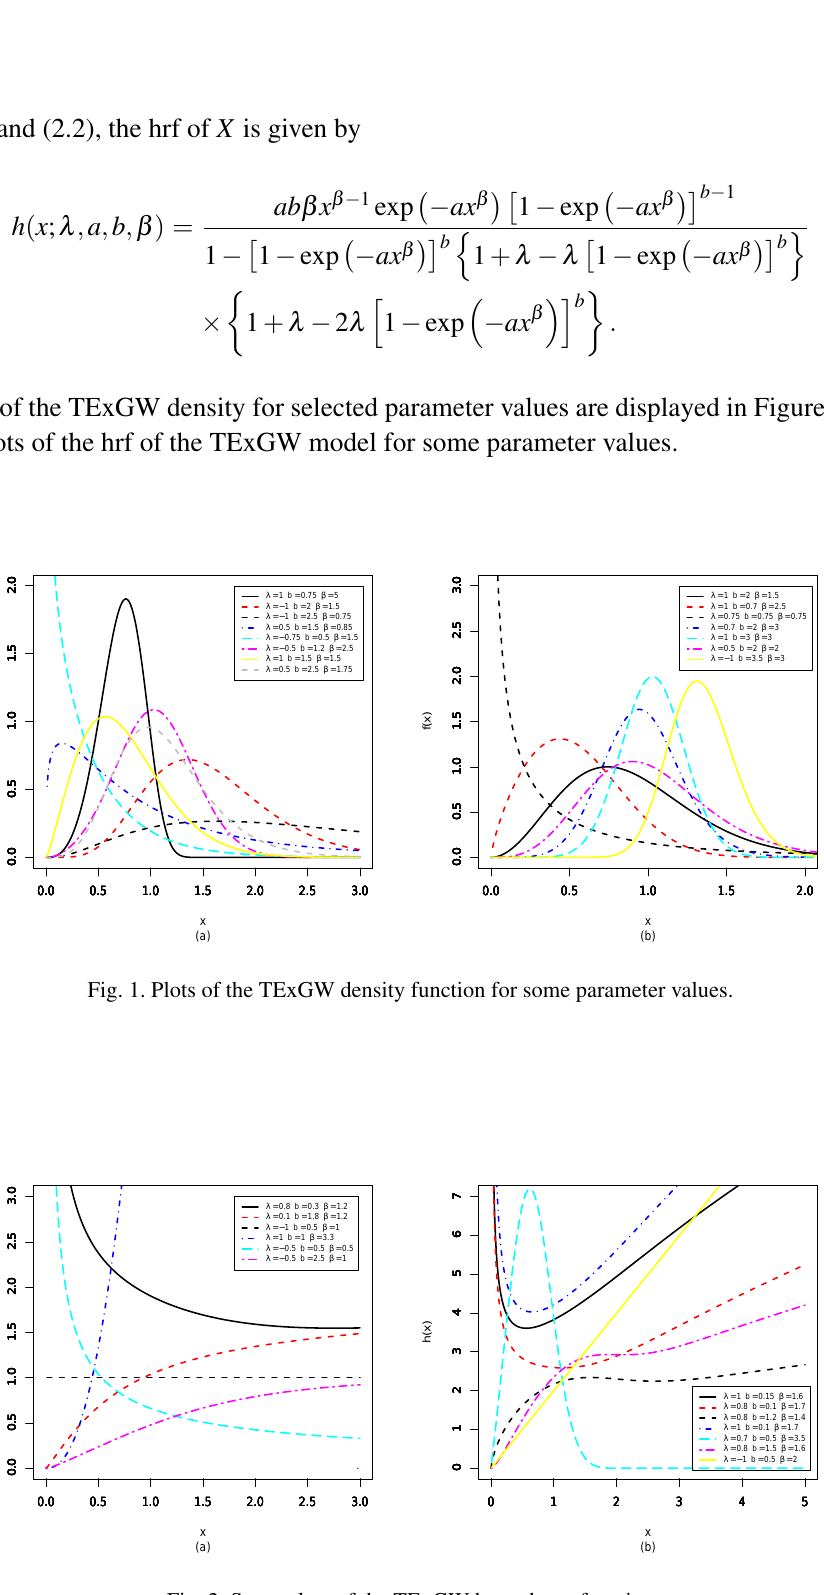
Fig. 2. Some plots of the TExGW hazard rate